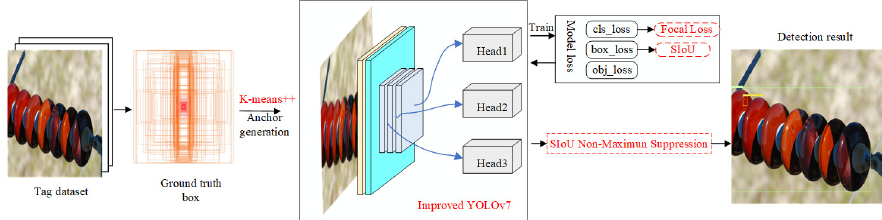
Figure 4. Detection framework of the proposed